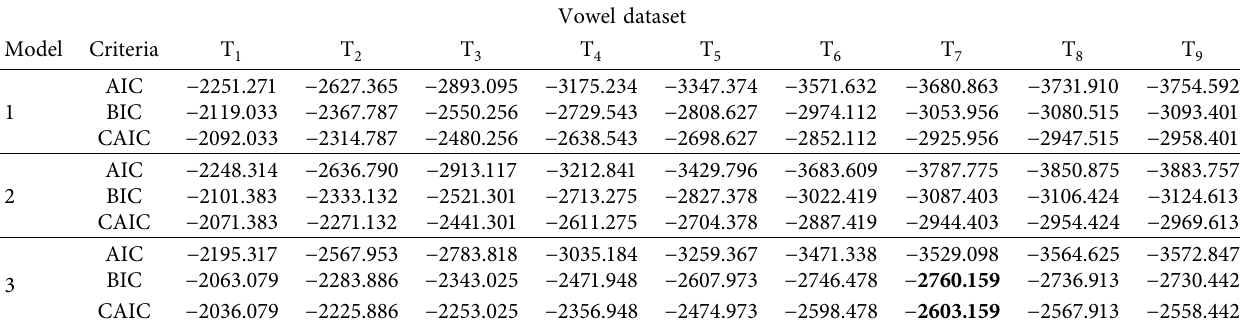
Table 9: Selection criteria values of the second scenario of the simulation